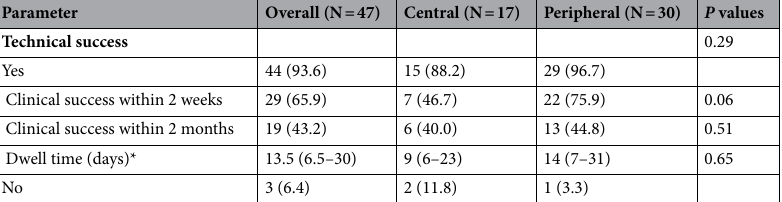
Table 3. Summary of technical and clinical outcomes of PICC placed using the PTA technique. Data in parentheses are the percentages except for the dwell time. *Calculated using the Kaplan–Meier Methods. Data in parentheses are the